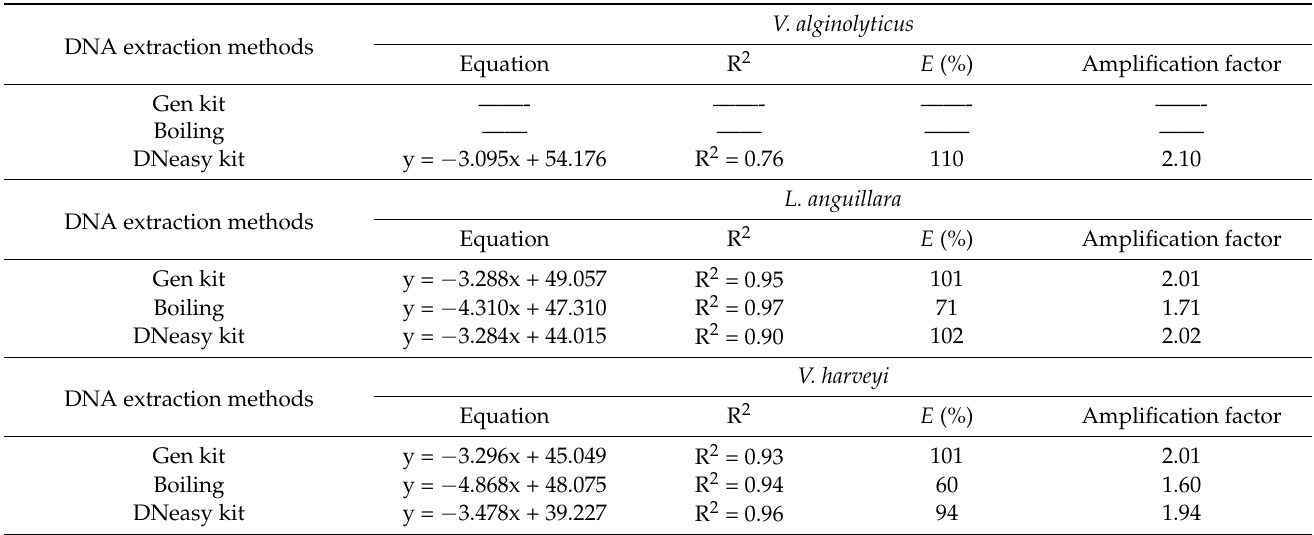
Table 2. V. alginolyticus , L. anguillara , and V. harveyi equations from the three DNA extraction methods (Gen kit, DNeasy kit, and boiling method). The R 2 and the amplification factor for each method are shown as well.